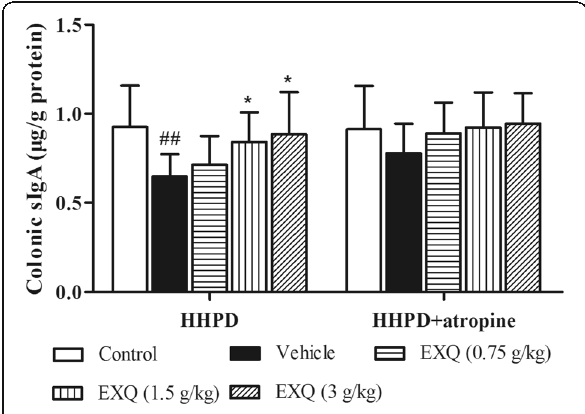
Fig. 3 Effects of EXQ on sIgA production in two models of experimental constipated mice. Data are shown as mean ± SD ( n = 8). # P < 0.05, ## P < 0.01 compared to the normal control group; * P < 0.05, ** P < 0.01 compared to the vehicle